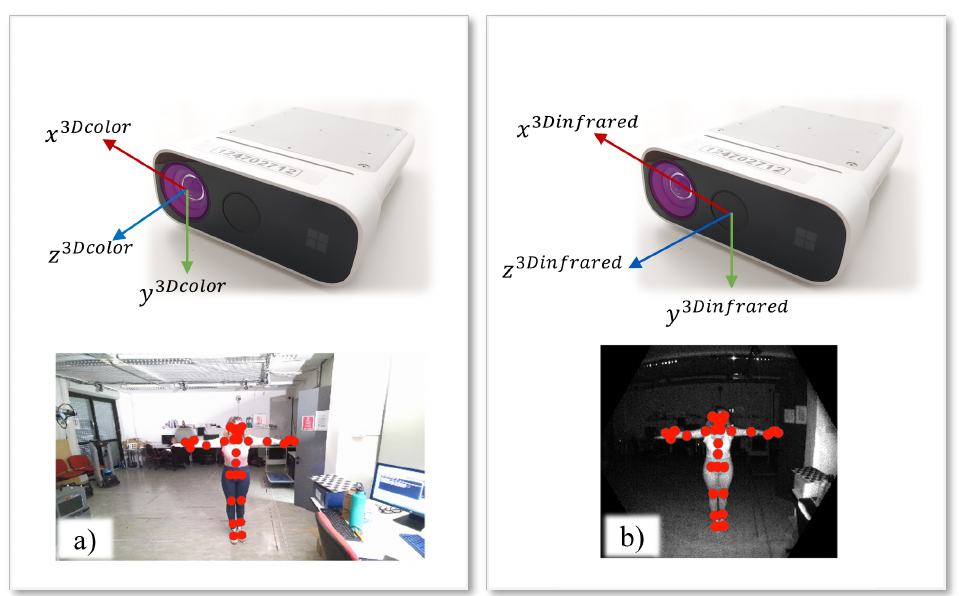
Figure 1. Representation of the internal Kinect sensors that produce: ( a ) color images with a resolution of 3840 × 2160 and ( b ) IR images with resolution 640 × 576. The origin of the coordinate systems is placed at the focal point of each sensor [11]. The skeletal joints extracted by the Body Tracking SDK are superimposed on the images.